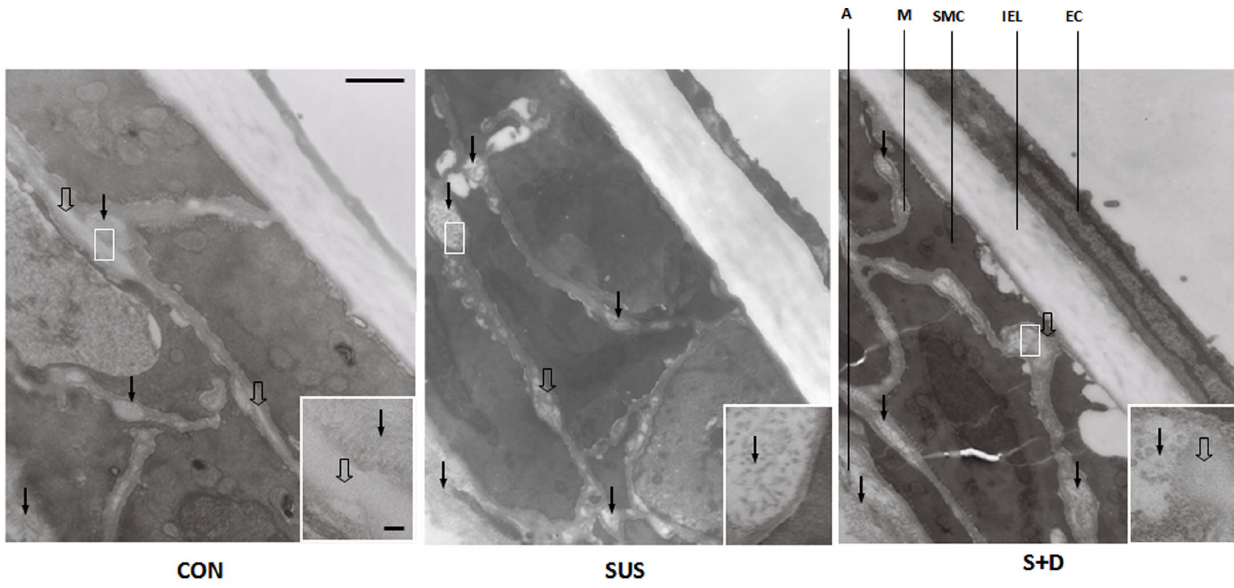
Fig. 4. Transmission electron micrographs of the longitudinal middlemost sections of the wall of middle cerebral arteries from a CON, a SUS, and a S + D rat. Vessel specimens were prefixed in passive state at their in-vivo length under 75 mmHg for 60 min. Acellular matrix components, collagen (closed arrows) and elastin (open arrows) are clearly visible and their details is further shown in each relevant inset. Vessel histology, with regions of internal elastic lamina (IEL), media (M), and adventitia (A), and endothelial cell (EC) and smooth muscle cell (SMC) is also clearly shown. Scale bar=500 nm. Electron micrographs in each inset, scale bar=50 nm.